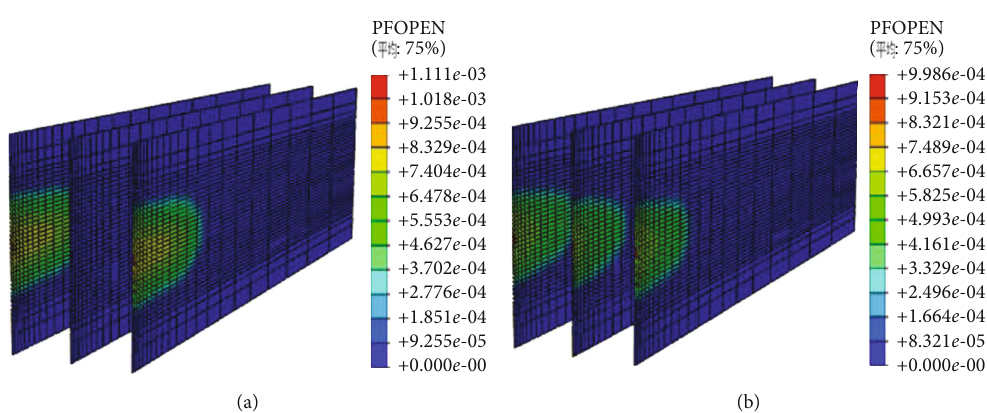
Figure 14: Fracture geometry after pumping for 50 s for di ff erent perforation frictions: (a) case 4; (b) case